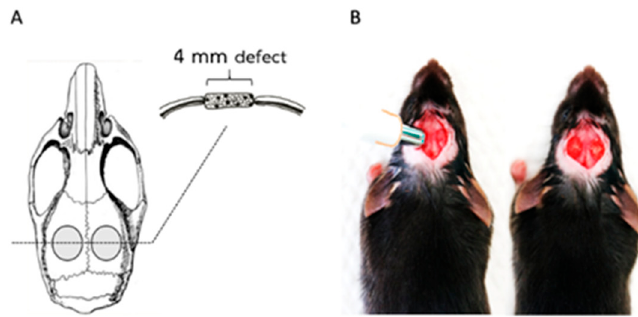
Figure 7. Mouse calvaria defect model. ( A ) Anatomical location of defects. ( B ) Defects were created using a biopsy punch and, in these defects, C/D scaffolds were inserted.